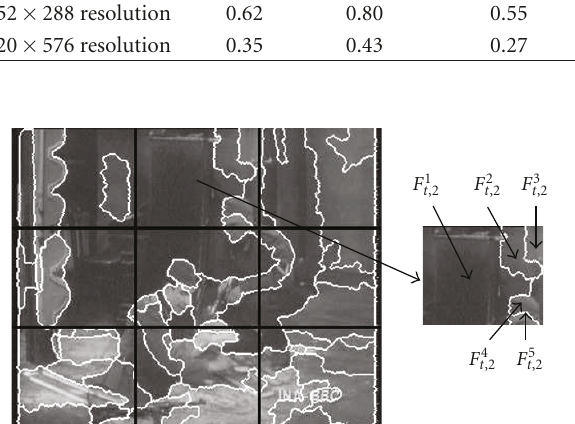
Figure 9: Segmentation and block-partitionning using a 3 × 3 grid of the 20th frame of the sequence Tunnel . Block partitioning ( B = 9) and the overlaid segmentation map are presented on the left, while the right figure illustrates the segmentation of block F t ,2 . ( k = 1, ... ,5) where local compensation profiles Sub-regions F k t ,2 are estimated are